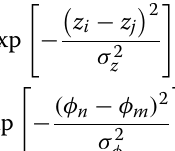
and correlation for vertical distribution, and between B ment of is as follows.